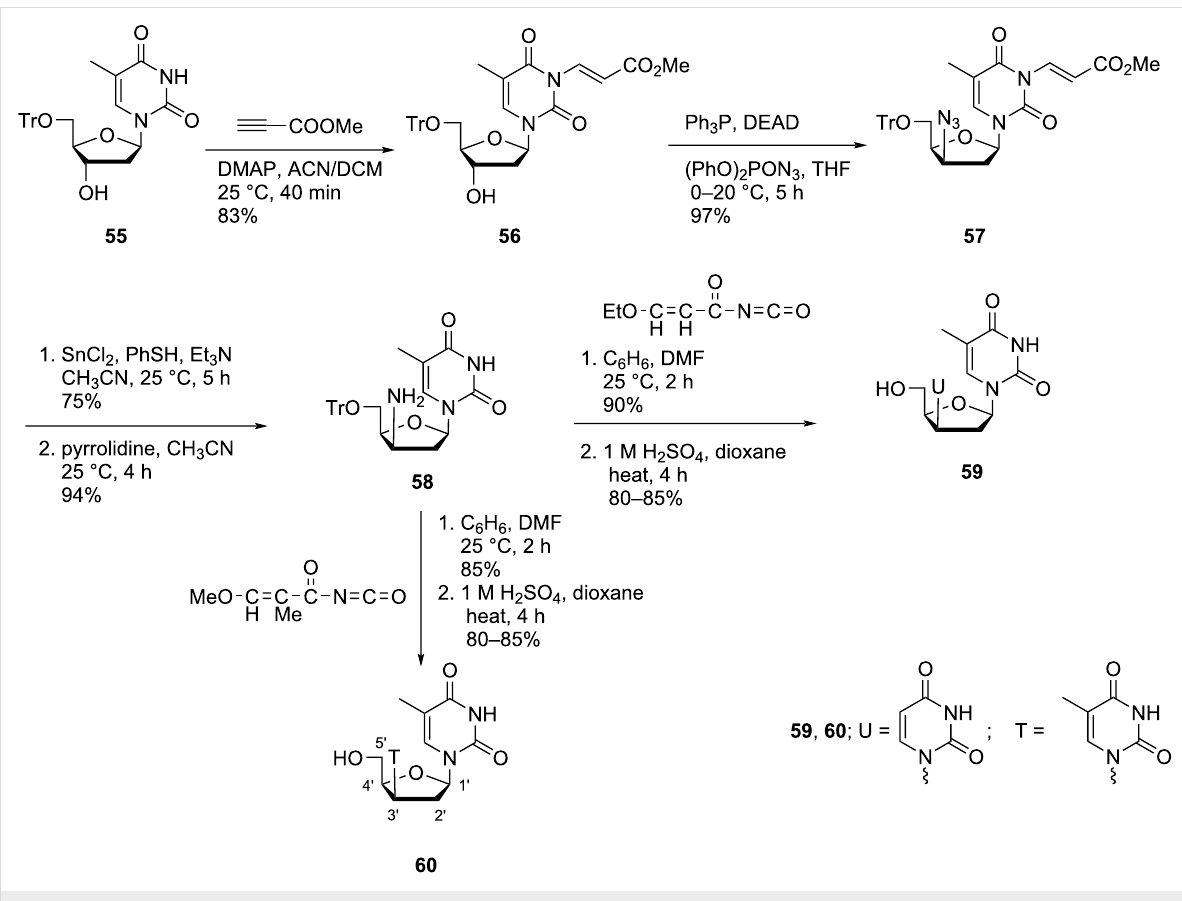
Scheme 13: Synthesis of double-headed nucleosides 59 and 60